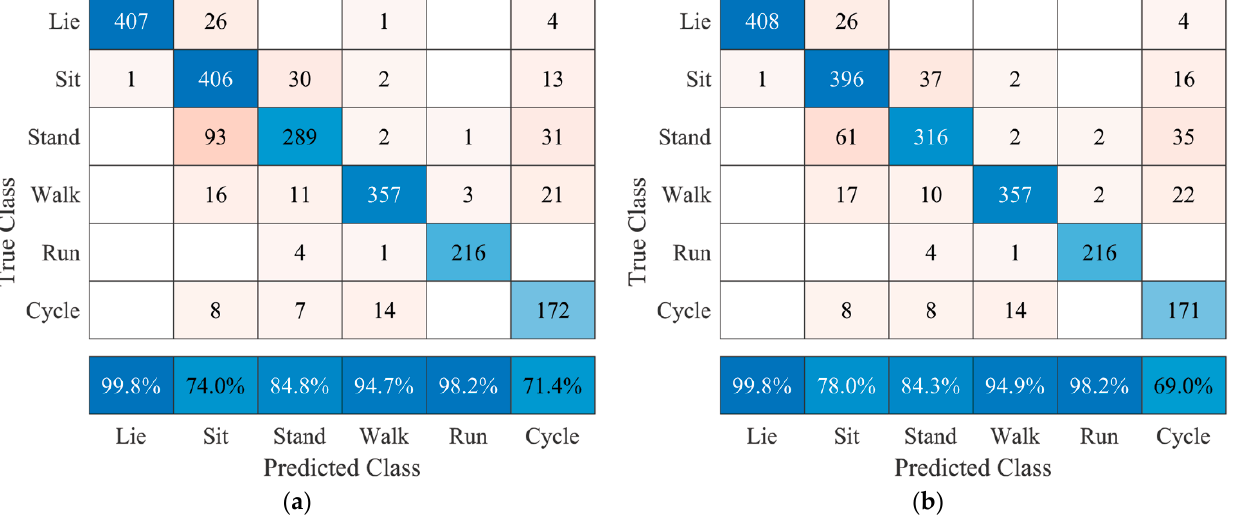
Figure 5. Confusion matrices after testing user-specific models using several sensor combinations of all seven subjects. ( a ) only sensor 3 (accuracy 86.5%); ( b ) sensors 3,4, and 5 (accuracy 87.3%). The bottom row represents the positive predictive ( a ) only sensor 3 (accuracy 86.5%); ( b ) sensors 3, 4, and 5 (accuracy 87.3%). The bottom row represents the positive predictive value for each posture or movement. value for each posture or Table 5. Classification results for different sensor combinations when using the AP™ and addi- tional sternum and/or upper leg sensors. Shown are mean accuracies (%) and the corresponding standard deviation of all seven subjects when developing user-specific or generalized models.